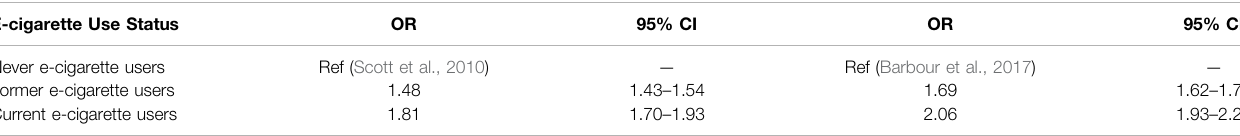
TABLE 3 | Association between E-Cigarette use and the risk of in fl ammatory arthritis diseases among US adults. E-cigarette Use